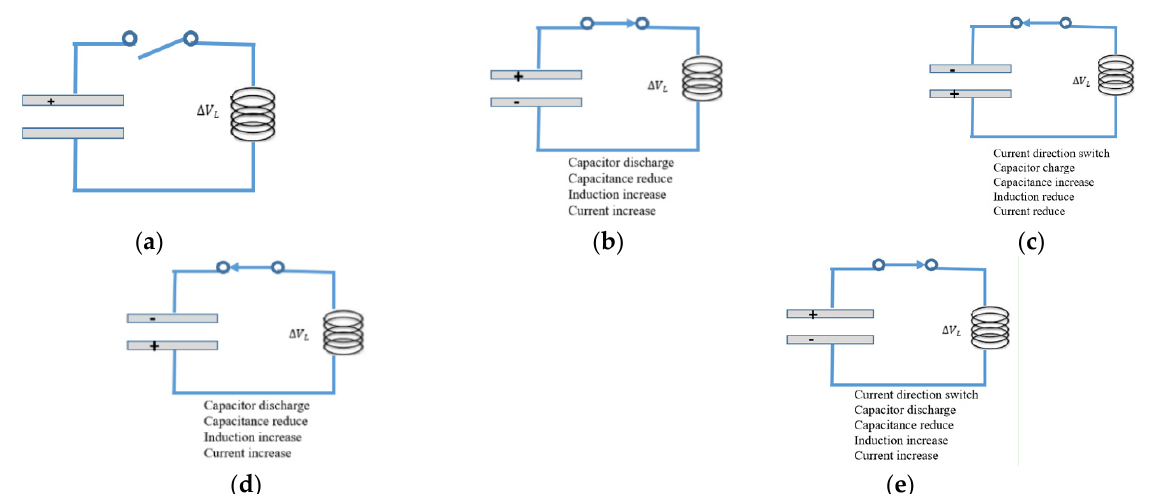
Figure 9. LC Circuit operation process flow ( a ) Initial stage; ( b ) Capacitor discharge; ( c ) Current direction switches; ( d ) Current discharge; ( e ) Current direction switches back to initial stage.